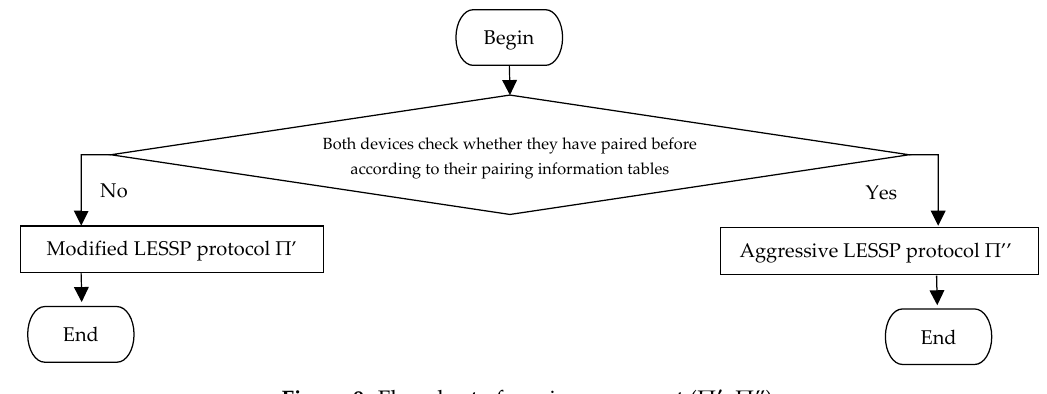
Figure 9. Flowchart of our improvement ( Π ’, Π ’’).